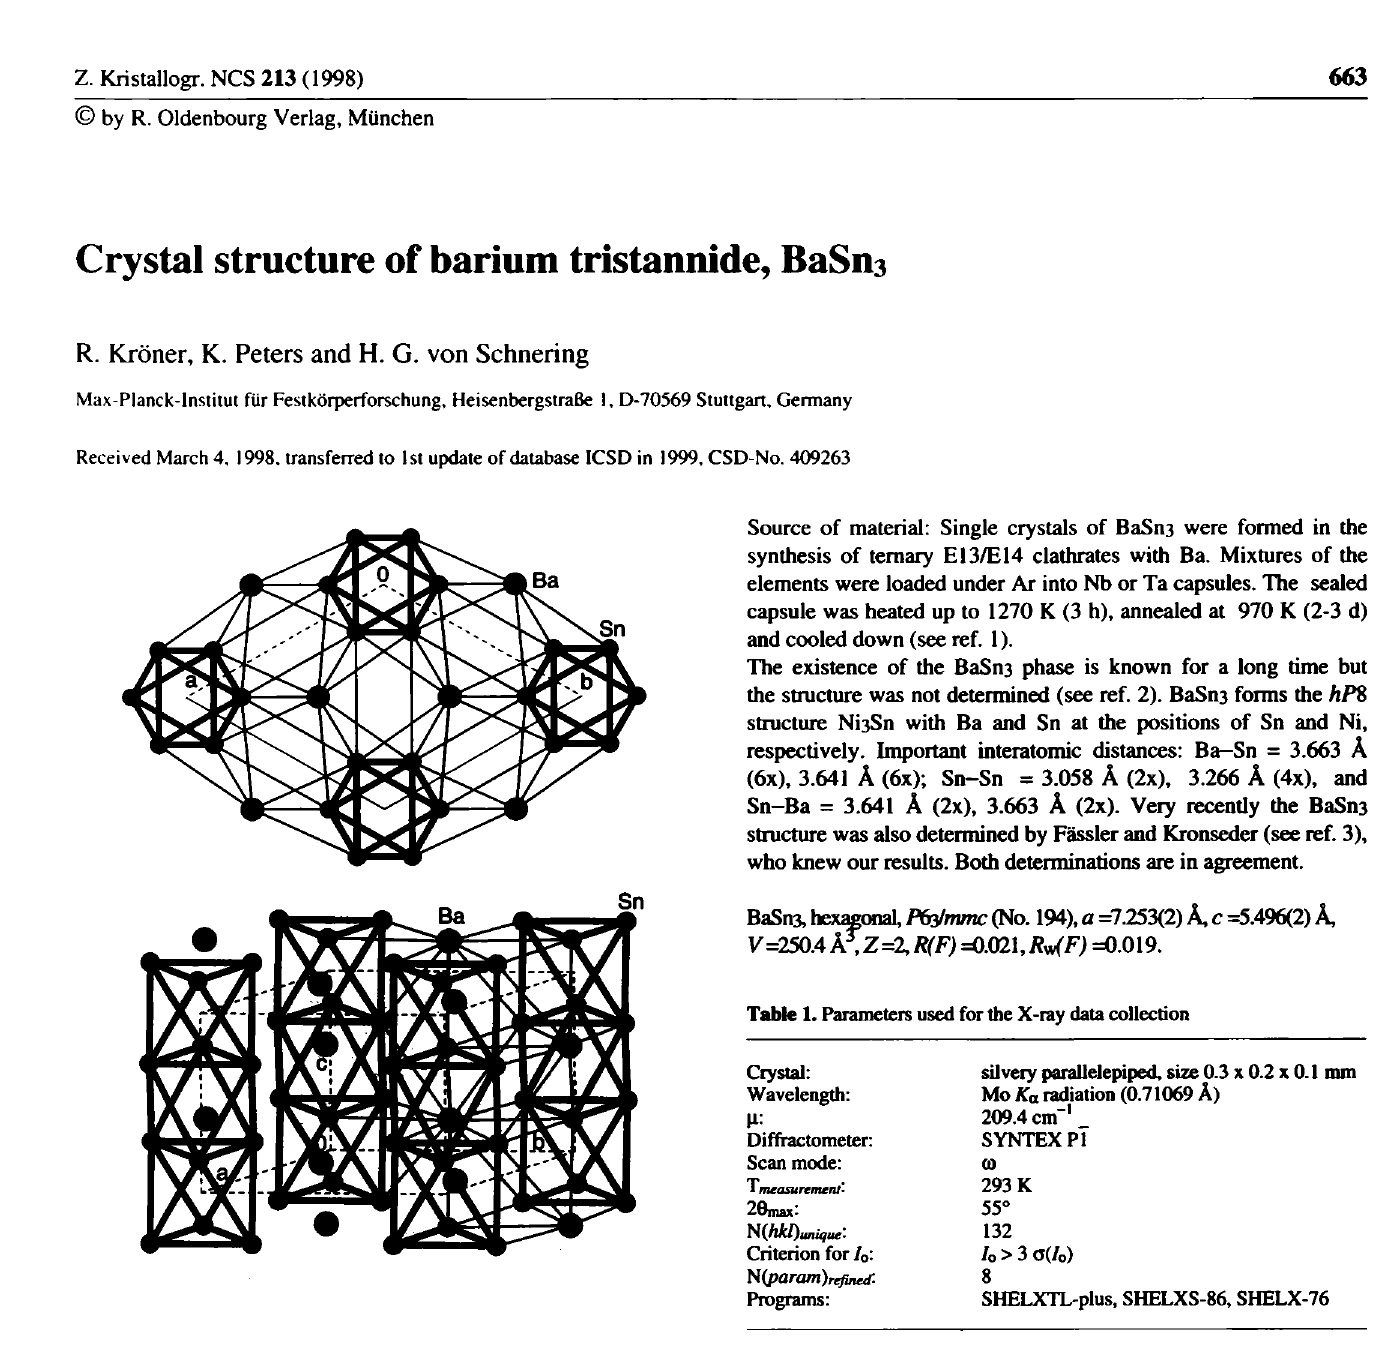
Table 2. Final atomic coordinates and displacement parameters (in Â^) Atom